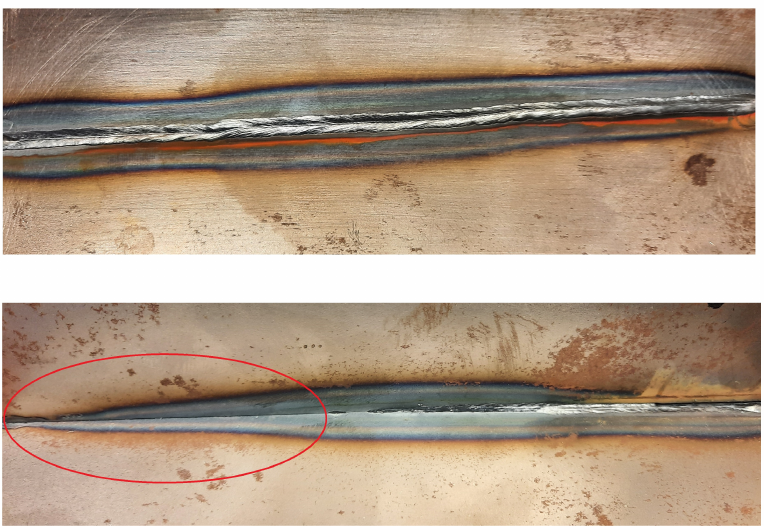
Figure 11. Top and root view of a weld seam with LB deviation from − 2.5 mm to 2.5 mm. Lack of fusion between the plates is indicated by red in the root